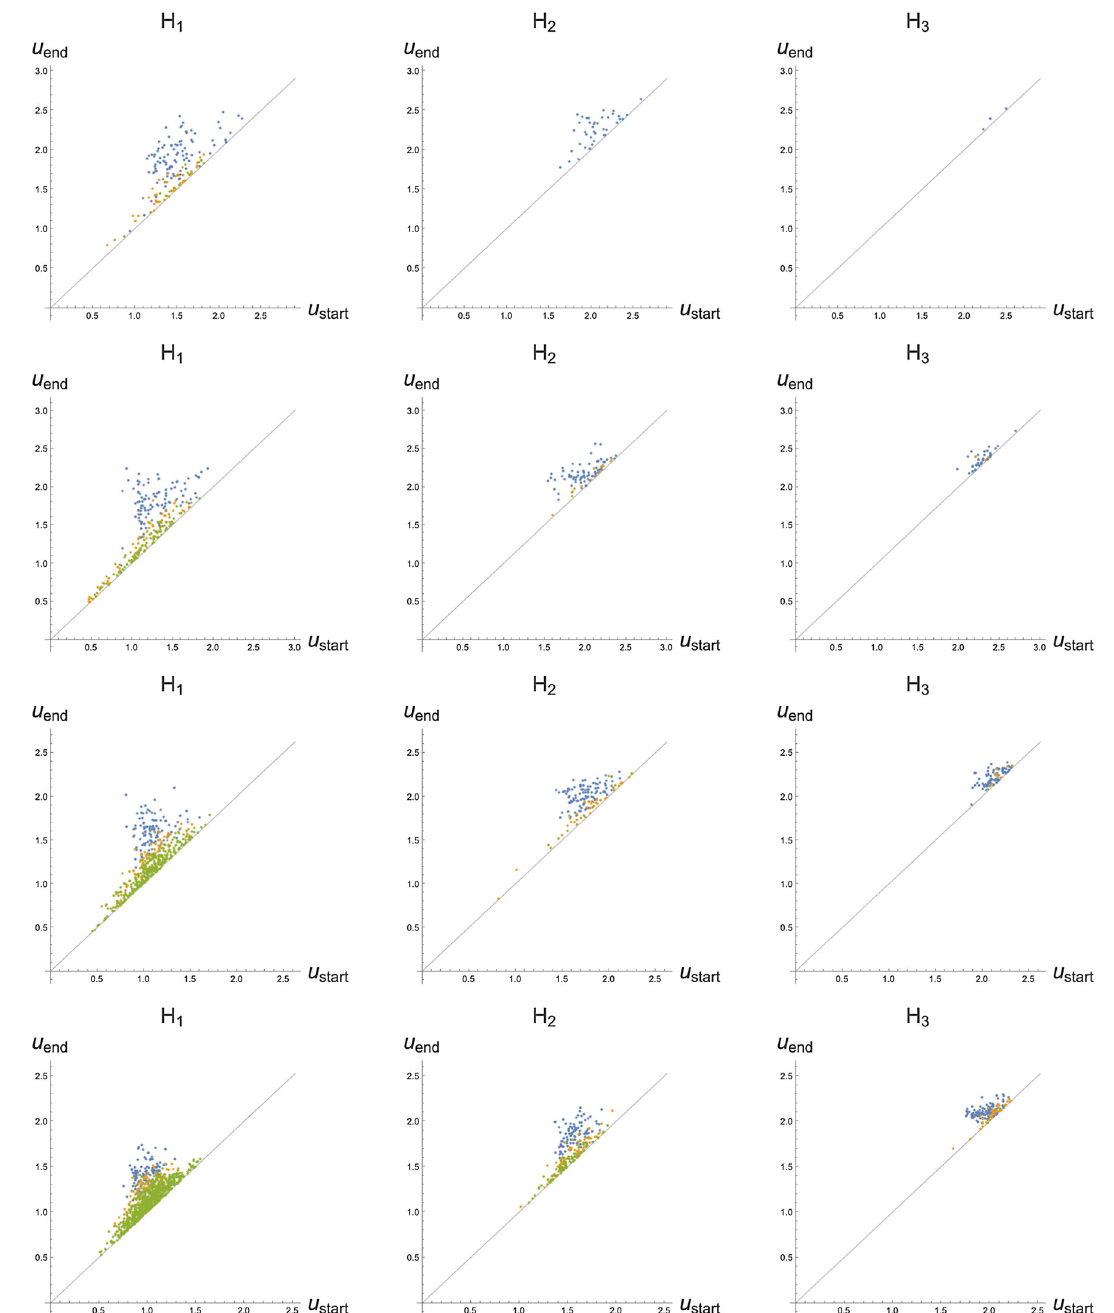
Fig. 7 Persistent diagrams obtained from the Monte Carlo data of N = 4 , k = 0 . 01 , λ = 1 with R = 10 , 15 , 20 , 25 (from the top to the bottom). To avoid the dependence of the initial values, 10 independent Monte Carlo sequences were run, and the sampling were performed uniformly from the sequence of updates of ∼ 10 9 after thermody- namic equilibriums were seen. 100 configurations of φ i a were uniformly sampled and the persistent homologies were analyzed (one- to three- dimensional homologies from the left to the right). The results of 100 samples are plotted on the same persistent diagrams. Blue dots repre-